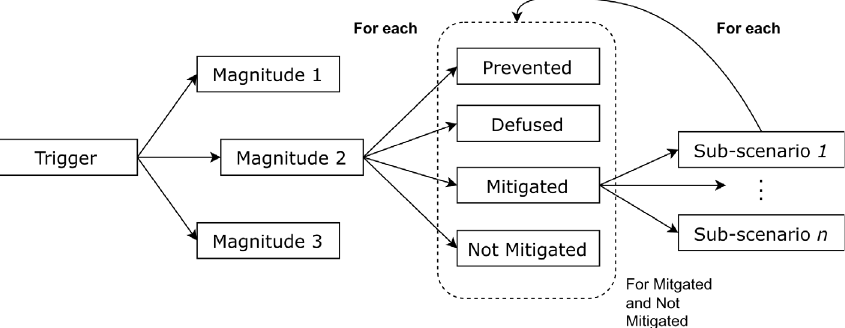
Figure 3. Risk Management Algorithm—Outcomes and cascade effect (sub-scenarios are run for each connected asset).